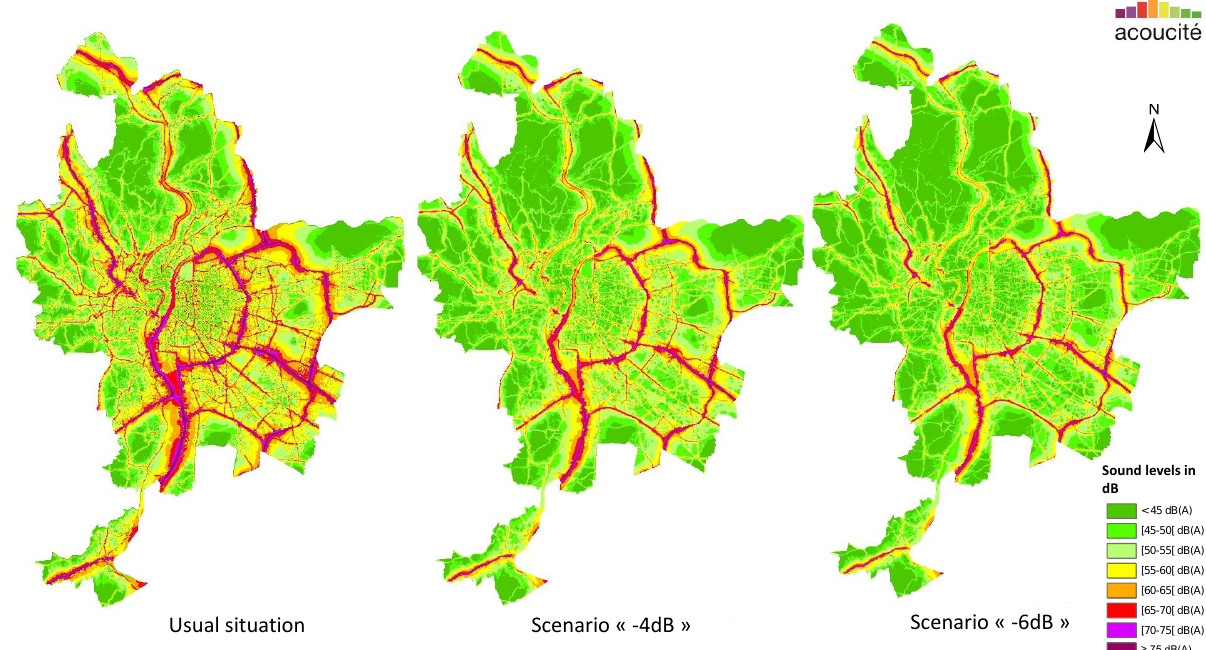
Figure 9: Road noise maps for the usual situation (left) and the scenarios “ − 4 dB” (middle) and “ − 6 dB” (right) for the Metropolis of Lyon (1.4 million